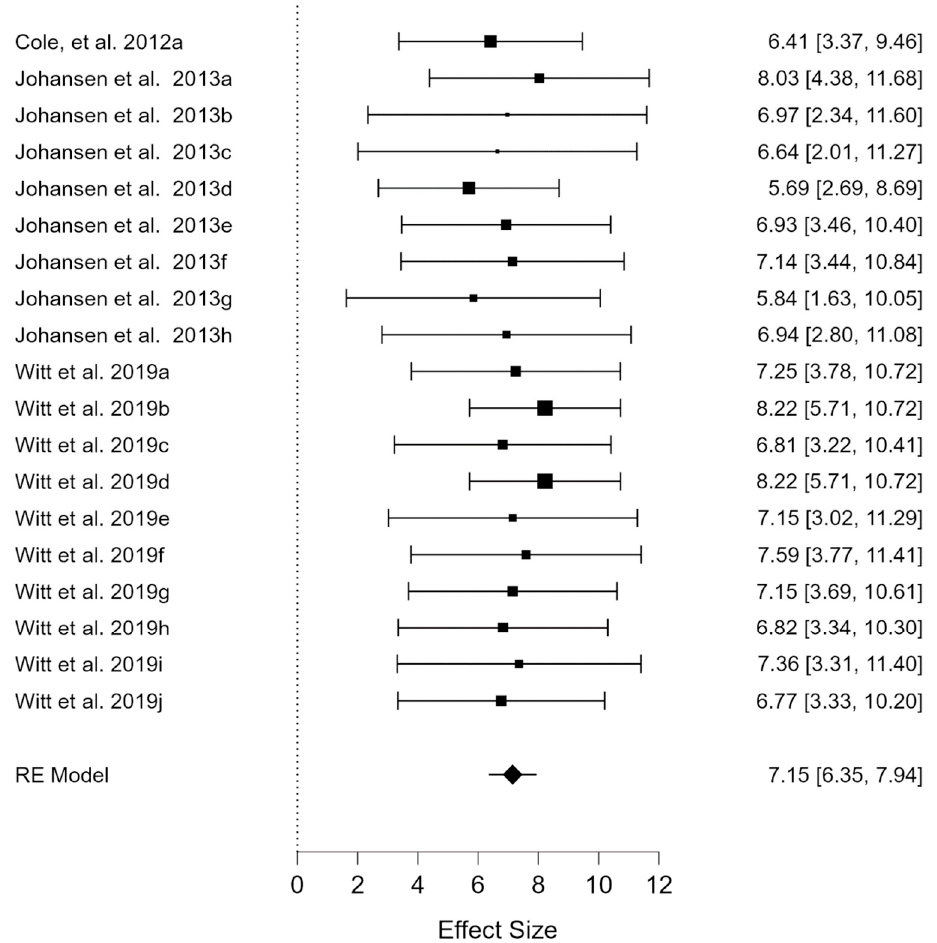
Figure 4. Forest plot of educational subscale [19,20,22]. Note: Each sample represented on the right-side effect size (lower limit, upper limit).